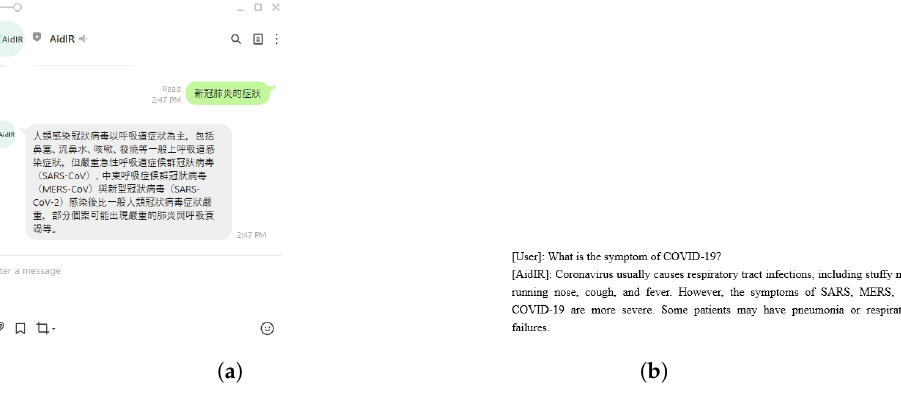
Figure 9. Results of information retrieval in AidIR: ( a ) original dialog; and ( b ) dialog in English.